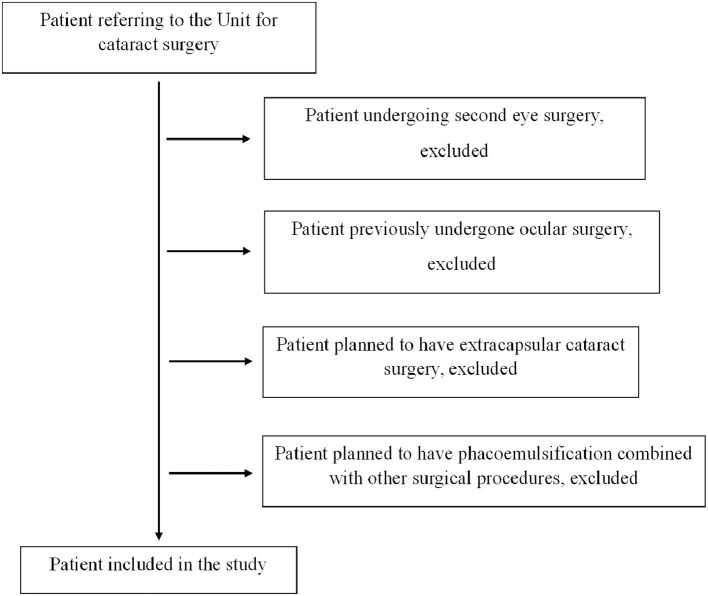
Flow chart showing the exclusion criteria for this study.